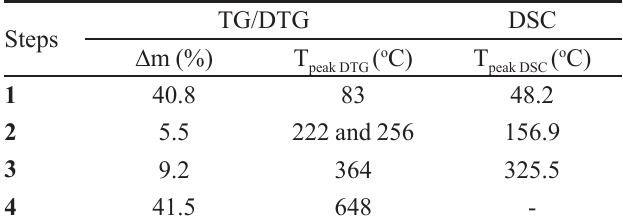
TABLE II - TG/DTG and DSC phytic acid data